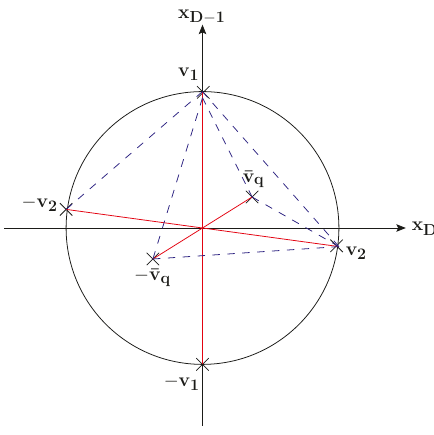
Figure 8 . Drell-Yan kinematics in terms of scaled vectors. Red lines indicate pairs of linear dependent vectors. The dashed blue lines mark contributions to genuinely different